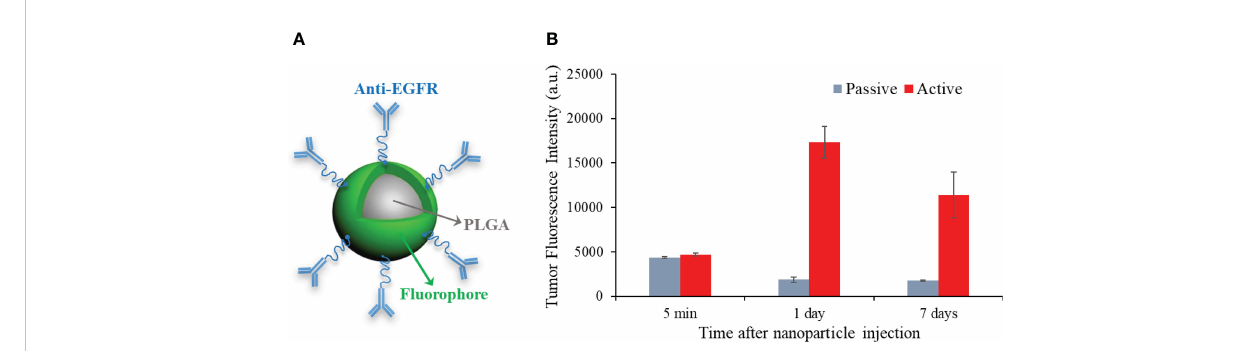
the fl uorescence image after geometric registration. As shown in Figure 3A, the fl uorescence emanating from the tumor (left solid circle) is overwhelmed by the nonspeci fi c signal from the gut (right dotted circle). Hence, it is dif fi cult to directly identify tumor only from raw fl uorescence image. The measured excitation distribution (shown in Figure 3B) exhibits large dynamic range, under the trans-illumination by a point source indicated in Figure 3C. The dotted circle region on Figure 3A was near the excitation source, therefore received much more excitation than the tumor area. In addition, the low absorption of the near- transparent bladder that localized around the dotted circle region may further enhance the transmission of light. Additionally, it is noteworthy that the two rectangle regions in Figure 3B correspond to the high-intensity excitation light re fl ecting from the residual hair (right rectangle) and the transparent animal holder (left rectangle), respectively. Although the fl uorescence fi lter can highly attenuate the excitation light (OD >10), small fraction of excitation light still leaked through the fl uorescence fi lter, as shown in the rectangle regions in Figure 3A. And in Figure 3A, the signal in the dotted circle region is much stronger than that in the rectangle region, which is opposite to the correspondent distribution in Figure 3B.